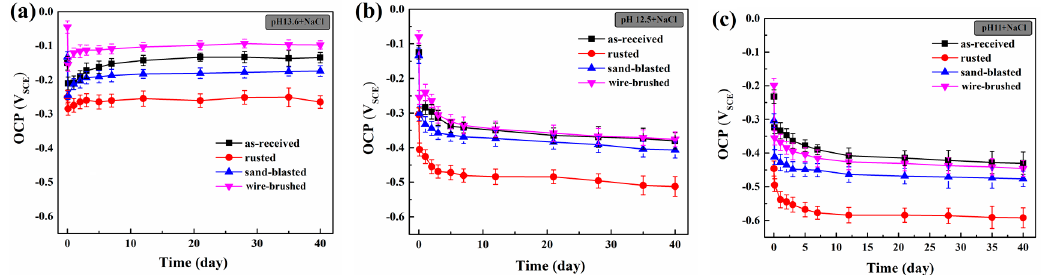
Figure 5. OCP evolution curves of the rebar immersed in the Cl − -contained SCPS of different ( a ) pH 13.6, ( b ) pH 12.5, and ( c ) pH 11. alkalinity: ( a ) pH 13.6, ( b ) pH 12.5, and ( c ) pH 11.